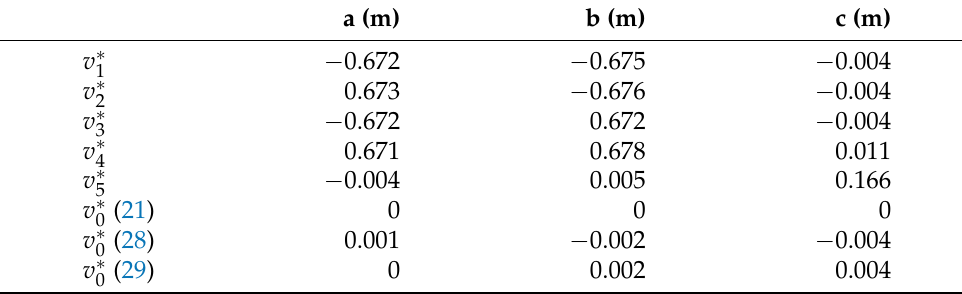
Table 1. Relative coordinates of the antennas and of the square